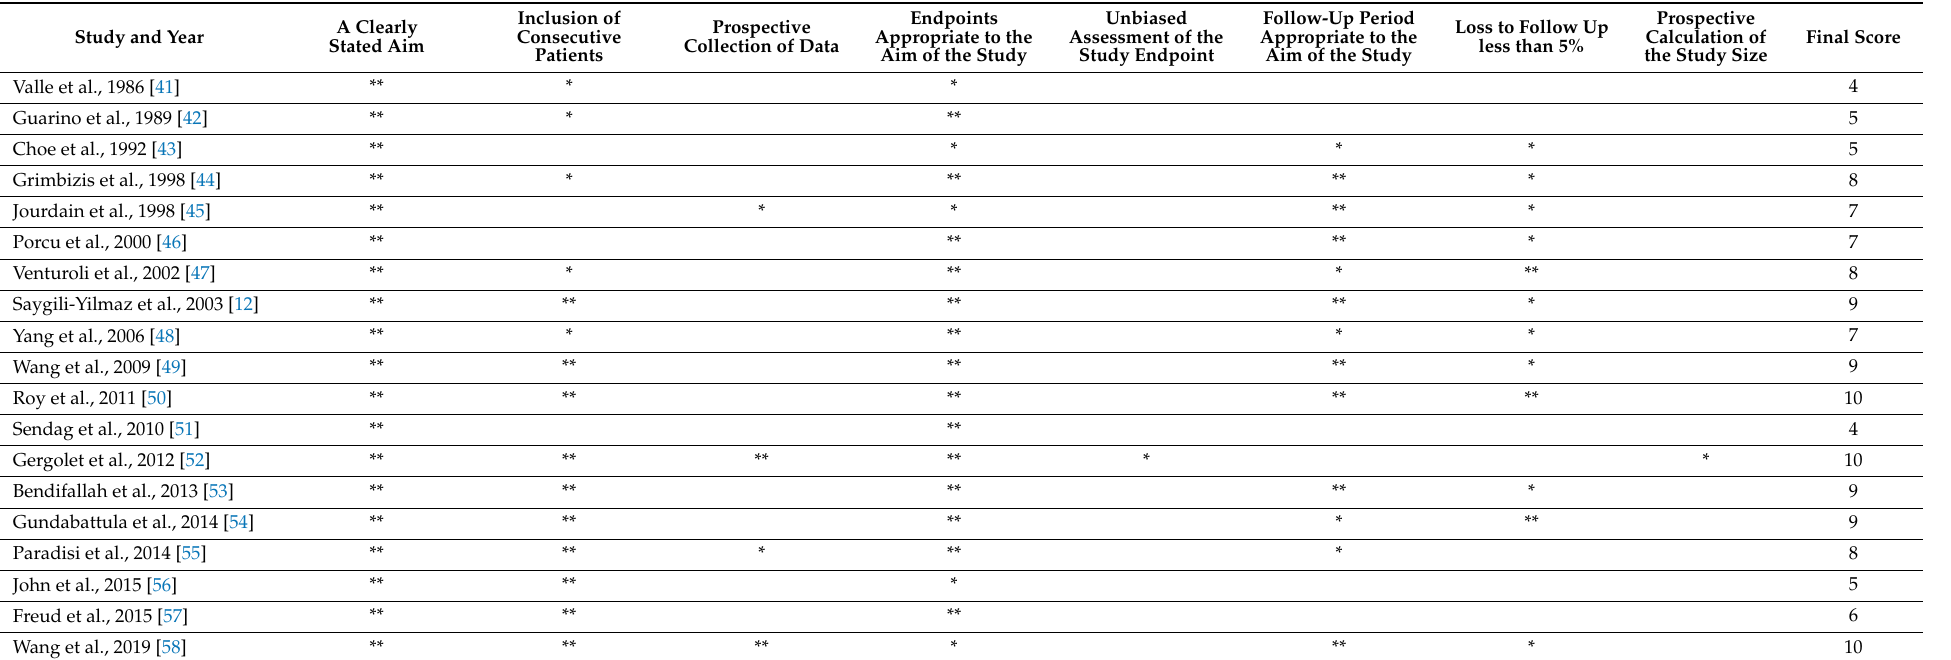
Table 6. Before and after septum removal—non comparative